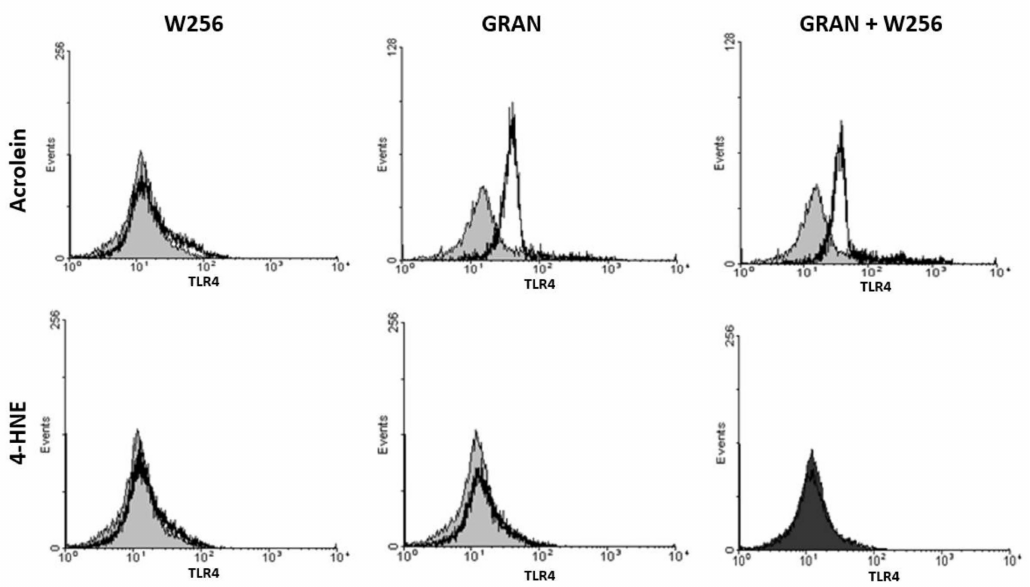
Figure 2. Representative flow cytometry histograms showing TLR4 surface expression on granulocytes and W256 tumor cells. Granulocytes and tumor cells were stained with antibodies specific for TLR4 (open histogram) or their isotype control (gray